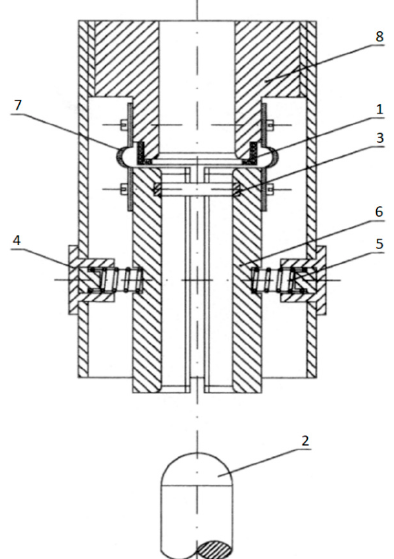
Figure 31. Tulip contact: 1—impactor; 2—movable contact with an arcing tip; 3—limiting ring; 4—compression spring guide; 5—compression spring; 6—pins; 7—flexible connection; 8—body of fixed contact.